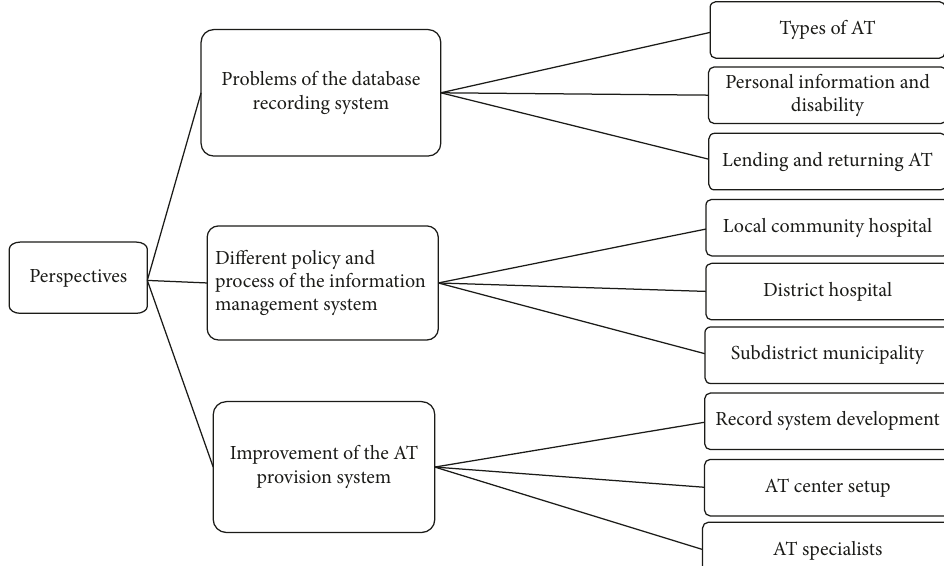
Figure 2: Perspectives of local policymakers and health service providers on information management in providing AT in the